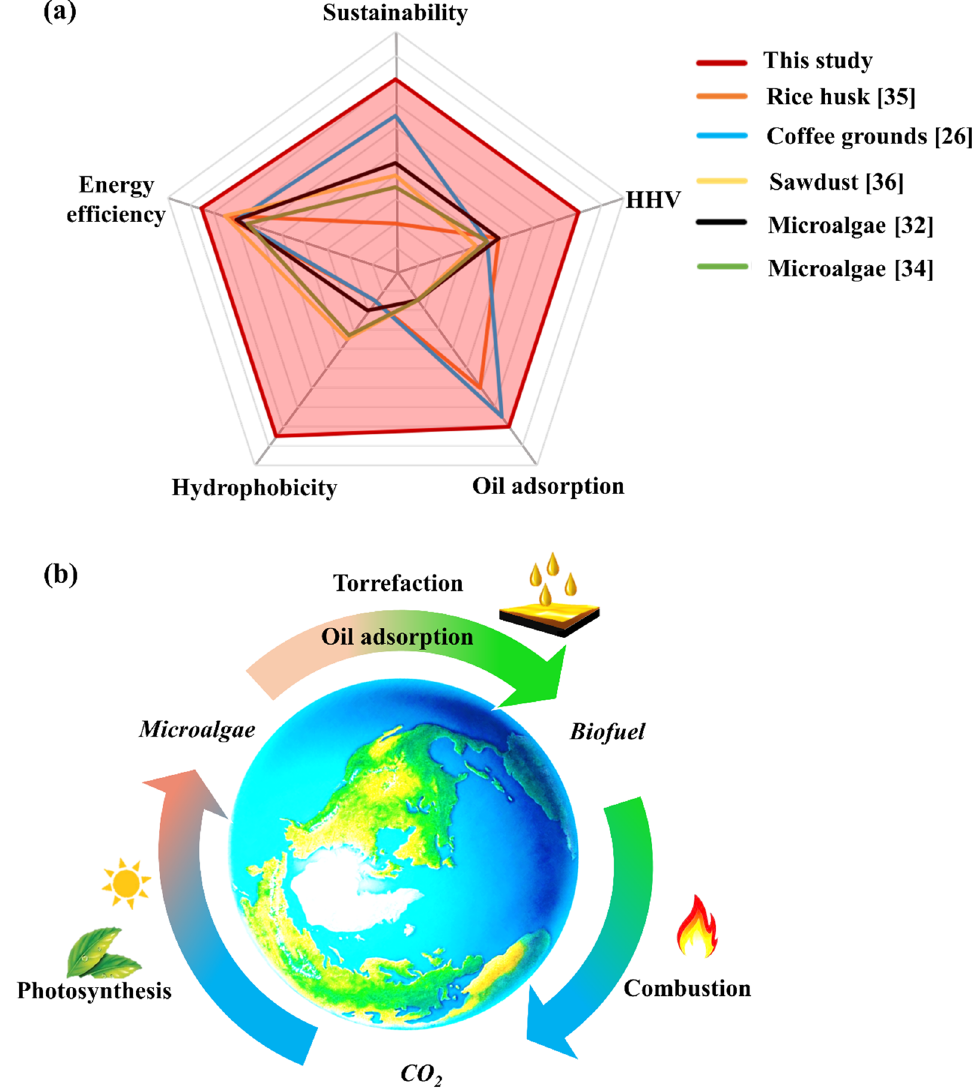
Fig. 8 The comparison between microalgal biochar and other materials from hydrophobicity, energy efficiency, sustainability, HHV, and